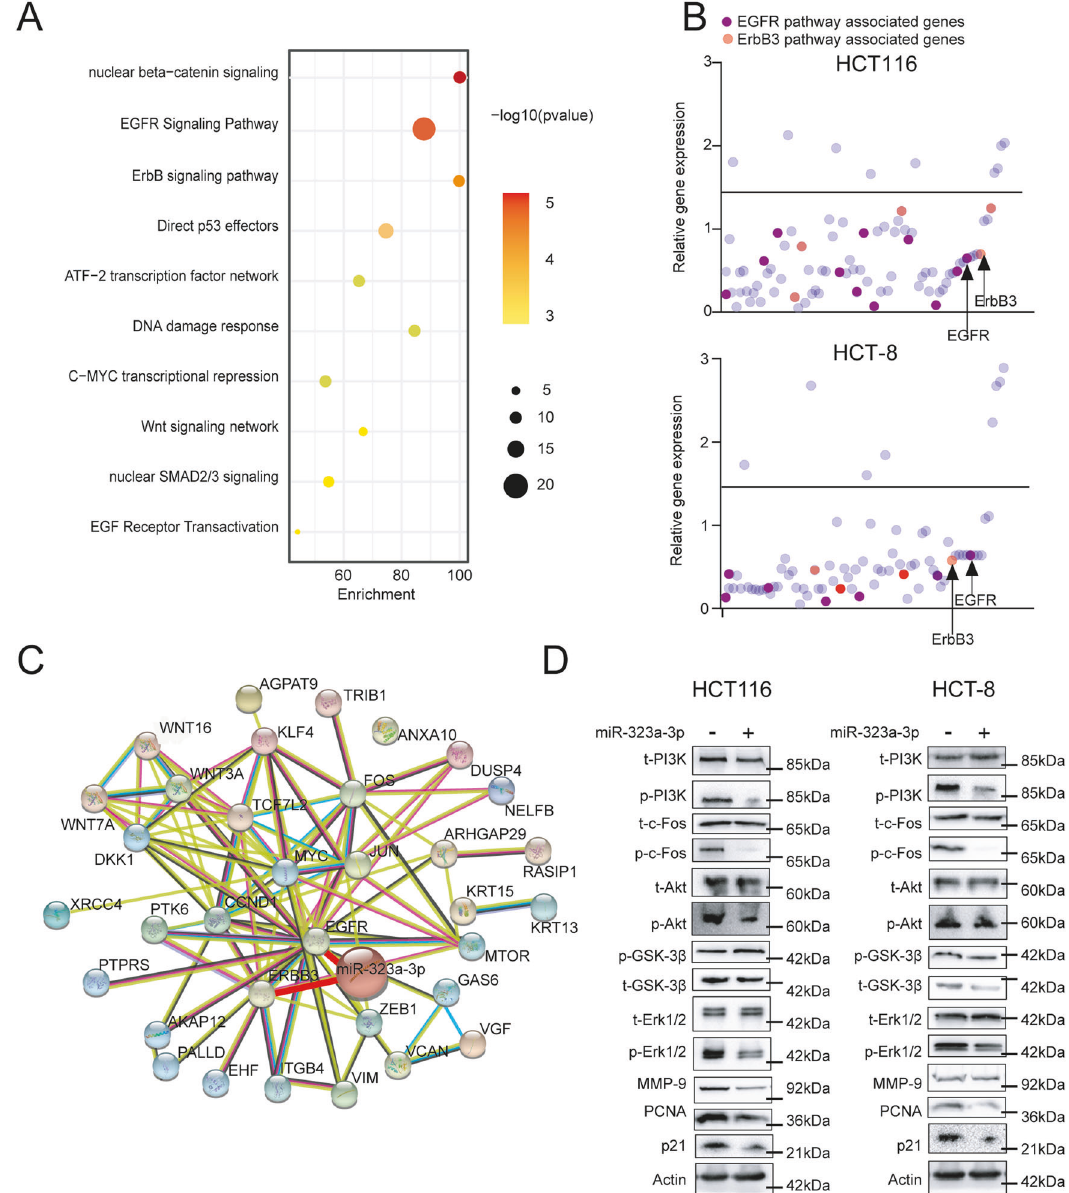
Fig. 4 The molecular regulatory network of miR-323a-3p. A MiR-323a-3p targeted EGFR and ErbB3 pathway by enriched KEGG pathways analysis. B MiR-323a-3p inhibited EGFR and ErbB3 at mRNA level in miR-323a-3p over-expression HCT-116 and HCT-8 cells. We detected the 88 most down-regulated genes in RNA-sequencing data. C We constructed the most down-regulated genes protein-protein interaction network by STRING-db, and miR-323a-3p could regulate this network. D MiR-323a-3p could inhibit PI3K, c-fos, AKT, GSK3 β , and Erk1/2 activation, and inhibit MMP9, PCAN, and p21